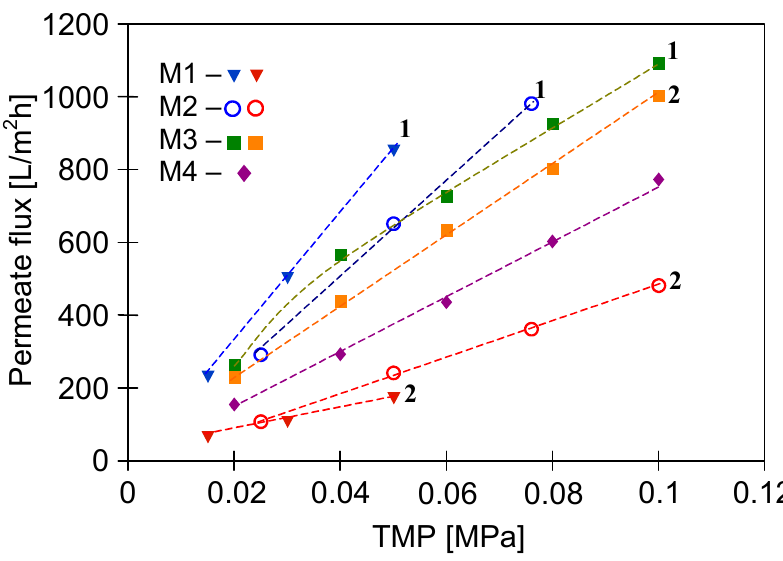
Figure 3. The maximum permeate flux as a function of transmembrane pressure (TMP): 1—after one operation of membrane wetting, 2—stabilized J 0 values after several operations of membrane wetting.